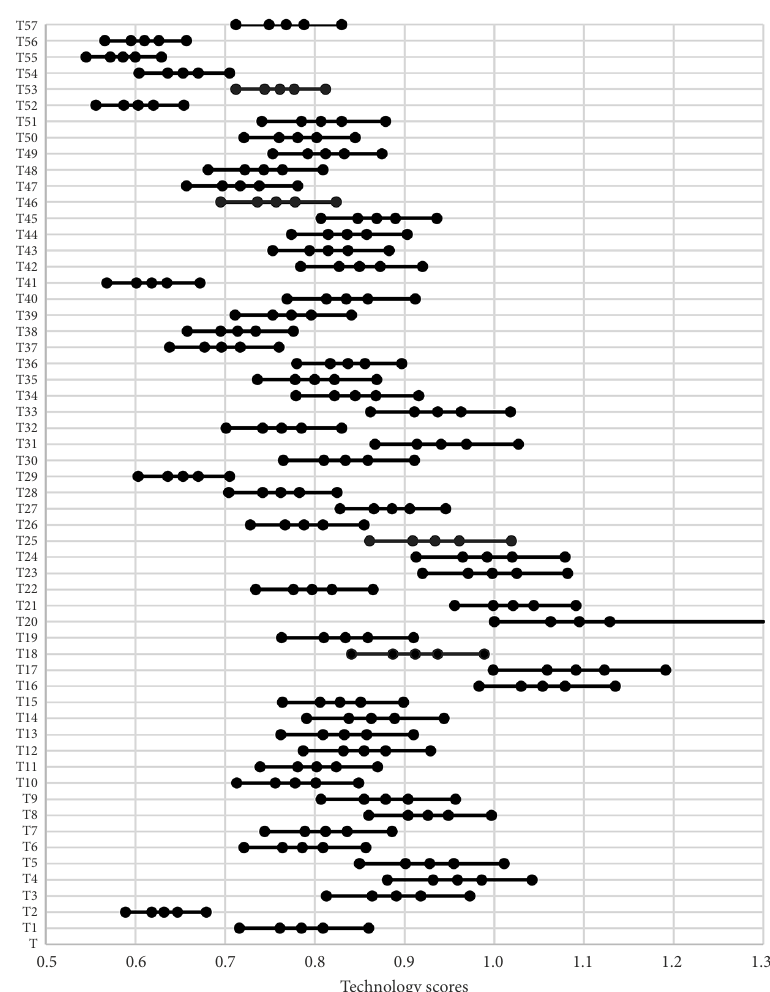
Figure 4. Technologies assessment by the hybrid